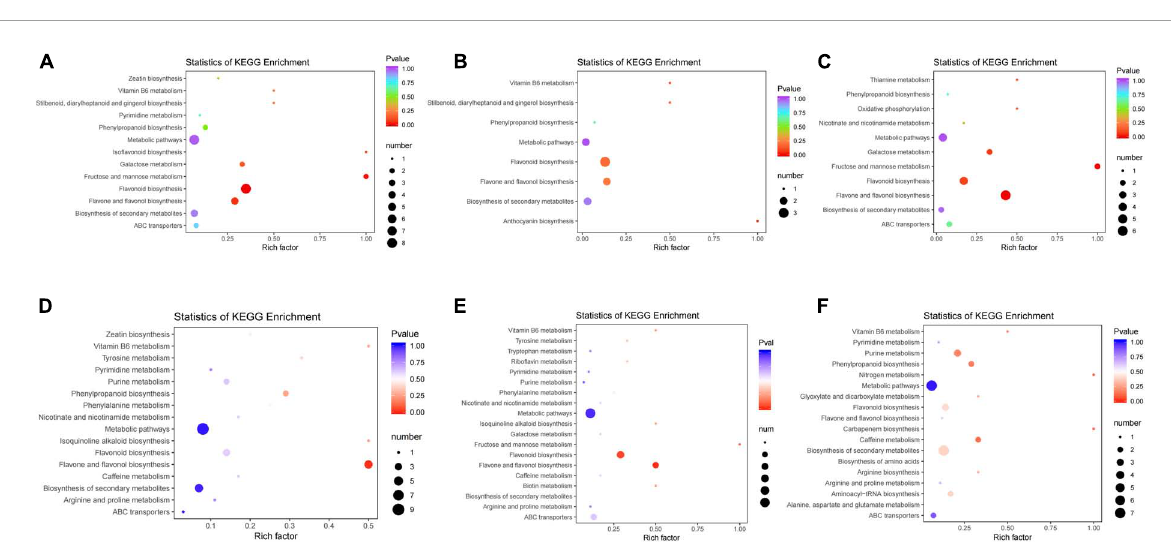
FIGURE10 KEGG pathway enrichment analysis of differential metabolites of groups JP and YX. (A) Tea-20 vs. Tea-200, (B) Tea-20 vs. Tea-1200, (C) Tea-200 vs. Tea-1200, (D) Tea-50 vs. Tea-100, (E) Tea-50 vs. Tea-400, and (F) Tea-100 vs.